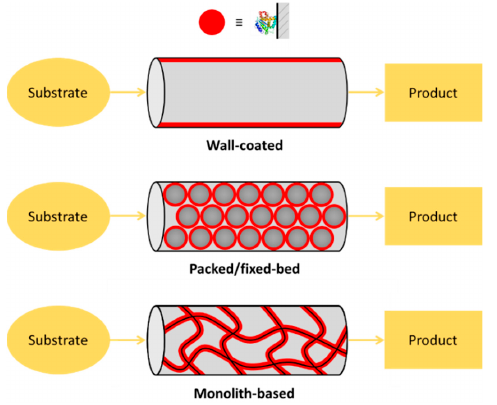
Figure 1. Types of enzyme-immobilized microreactors. (1) Wall-coated enzyme-immobilized microreactor, where the enzyme is directly adsorbed onto the inner surface of the microchannels or capillary. (2) Packed/fixed-bed enzyme microreactor, where the enzyme is pre-immobilized into particles/beads that are packed. (3) Monolithic microreactor, where the enzyme is immobilized onto the surface of the pores/channels of a monolithic material.